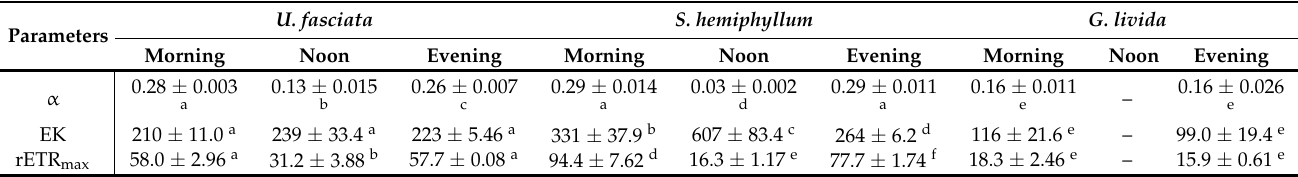
Table 2. The rapid light curve (RLC)-derived light utilization efficiency ( α ), saturation irradiance (E K , µ mol photons m − 2 s − 1 ), and maximum relative electron transport rate (rETRmax) of U. fasciata , S. hemiphyllum and G. livida grown in field condition, measured at morning, noon and nighttime. Numbers show the mean and standard deviations (mean ± sd) ( n = 3); and different letters on top-right of number indicate the significant difference among three measured time-periods ( p < 0.05).